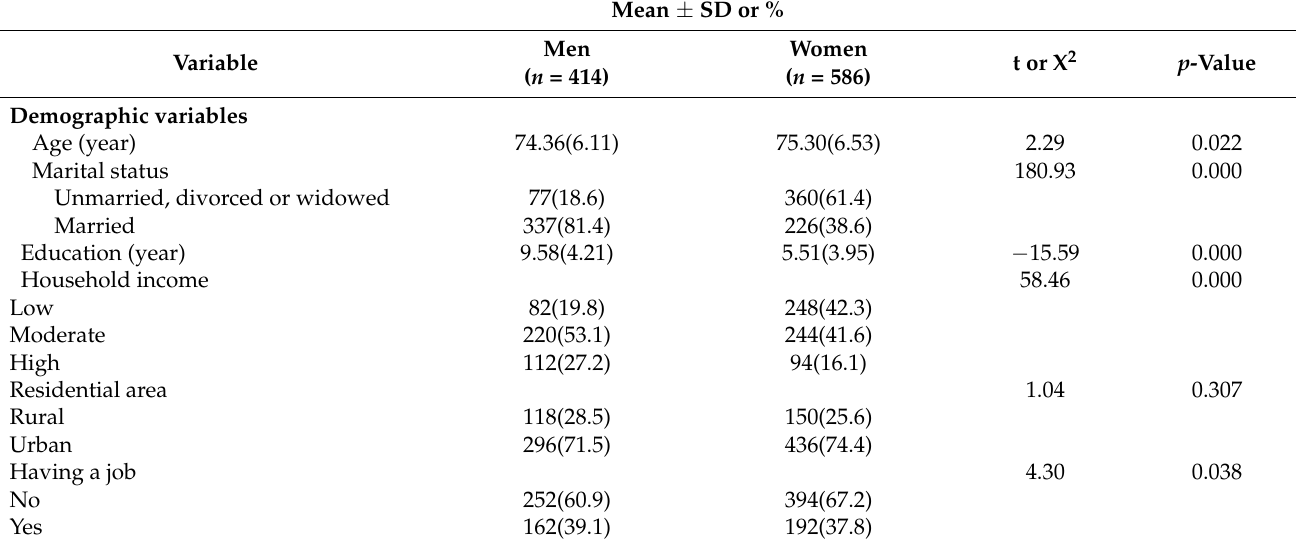
Table 1. Descriptive characteristics of the participants by gender ( n =